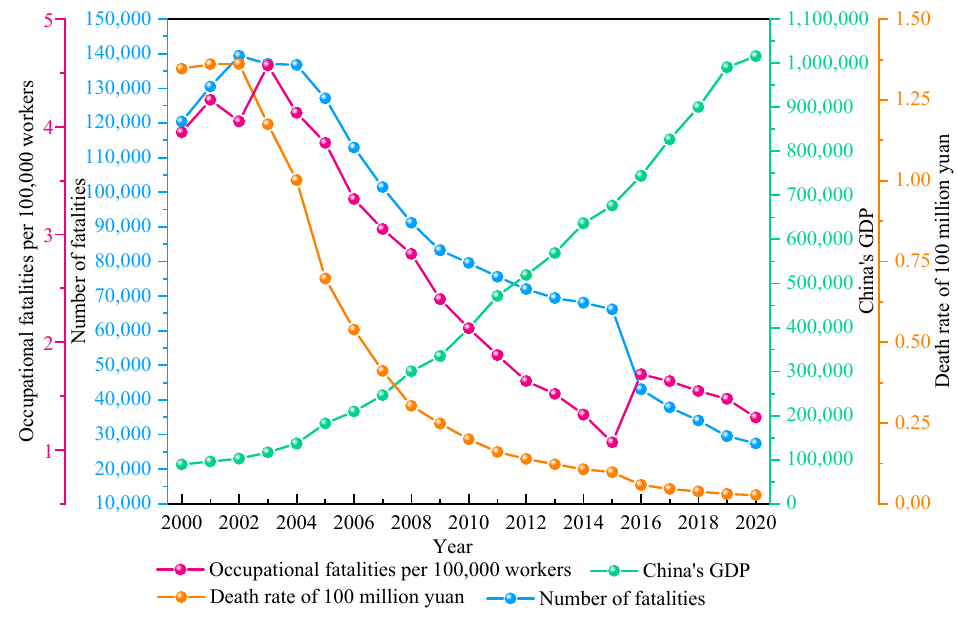
Figure 2. Changes in occupational accidents and economic data in China.